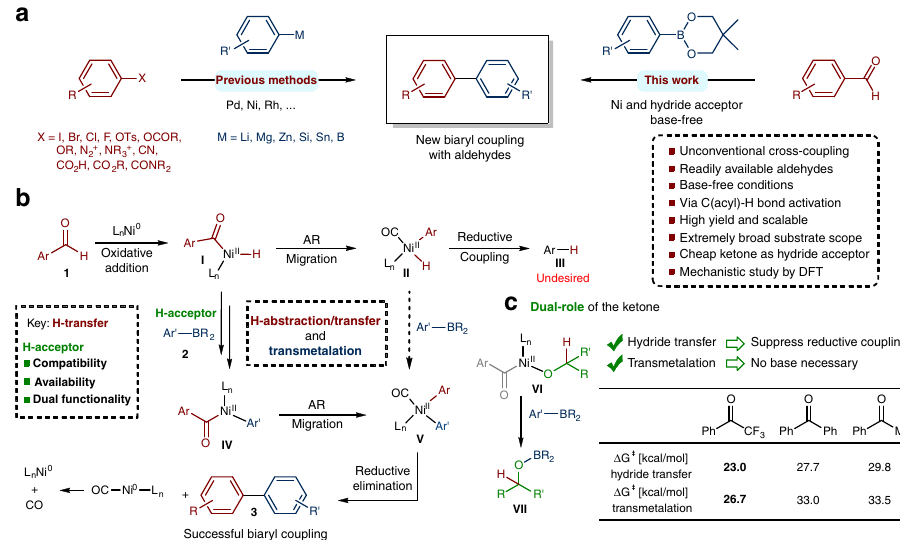
Fig. 1 Nickel-catalyzed deformylative Suzuki – Miyaura cross coupling and related DFT studies on the role of tri fl uoroacetophenone. a Previously reported transition-metal-catalyzed construction of biaryl motifs (left) and nickel-catalyzed deformylative cross coupling for the synthesis of biaryls (right). b Proposed mechanism for the nickel-catalyzed arylation of aldehydes. c Dual-role of the ketone in the hydride-transfer and transmetalation